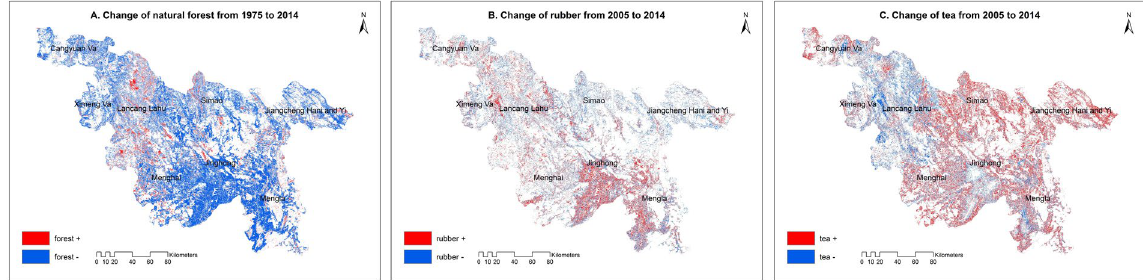
Figure 3. Spatial changes of different land cover (“ + ” means the appeared area; “ − ” means the disappeared area). ( A ) change of natural forest from 1975 to 2014; ( B ) change of rubber from 2005 to 2014; ( C ) change of tea from 2005 to 2014. Software: ArcGIS 10 . 2 ( ESRI Ltd ., CA , USA . www.esri.com).